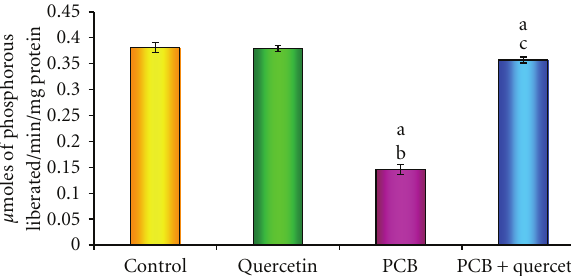
Figure 4: E ff ect of quercetin on protein carbonyl content in hip- pocampus of PCBs-exposed adult rats. Each bar represents mean ± SEM of 6 animals. Statistical significance is at P < 0 . 05 (a: Control versus others; b: Quercetin versus PCB, PCB + Quer; c: PCB versus PCB + Quer).